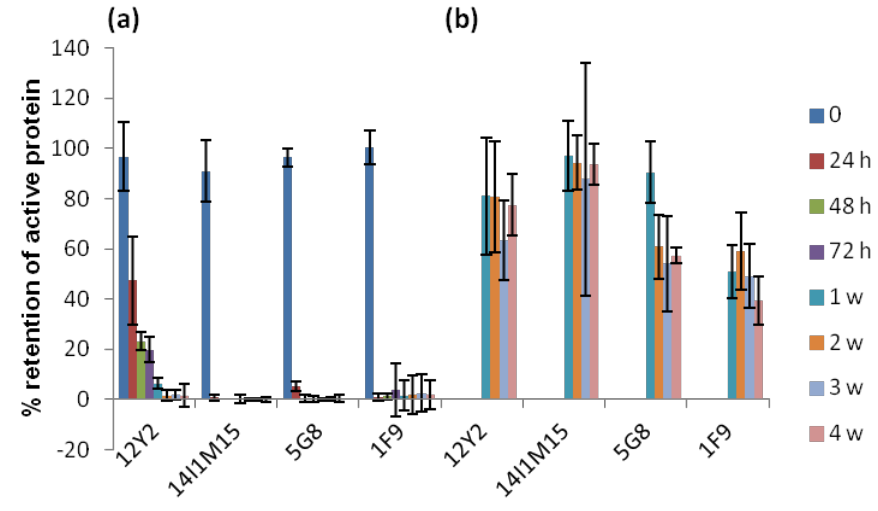
Figure A3. Retention of active V s 12Y-2 and 14I1M-15, and mAbs 5G8 and 1F9 NAR following heating at 60 °C in ( a ) liquid and ( b ) lyophilized formats, as determined by biosensor analysis. Method described in Section